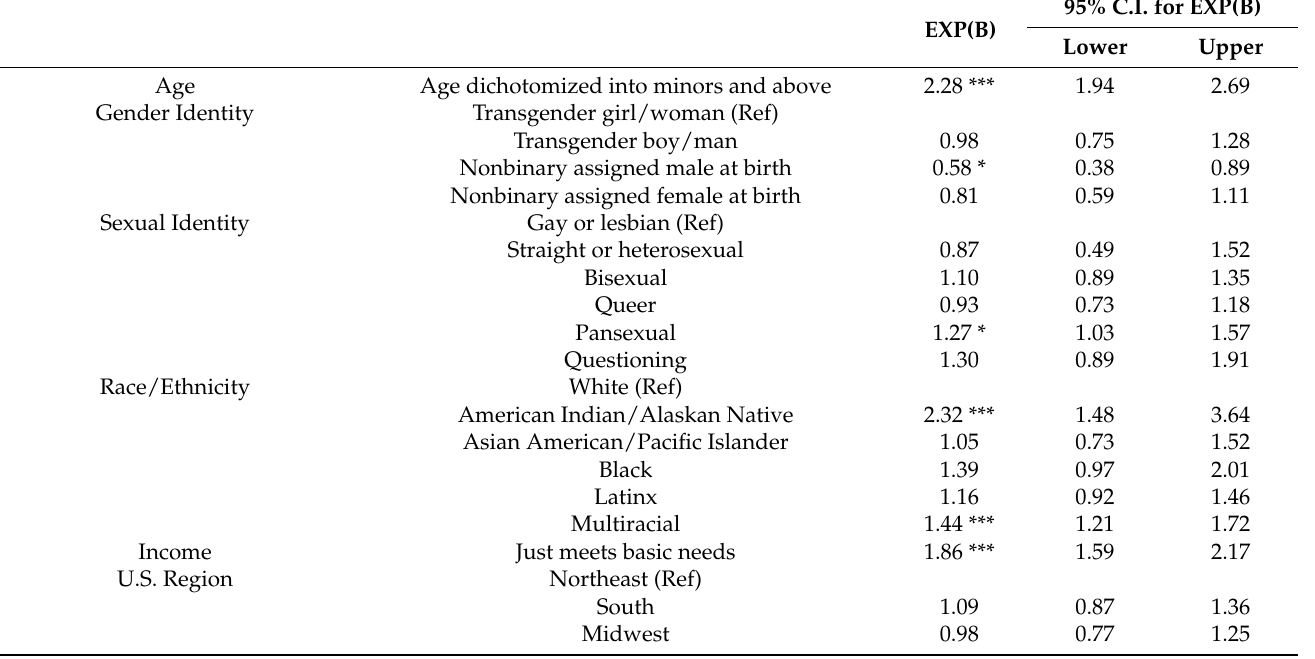
Table 2. Multivariate logistic regression results on the association between updating identification documents and likelihood of attempting suicide in the last 12